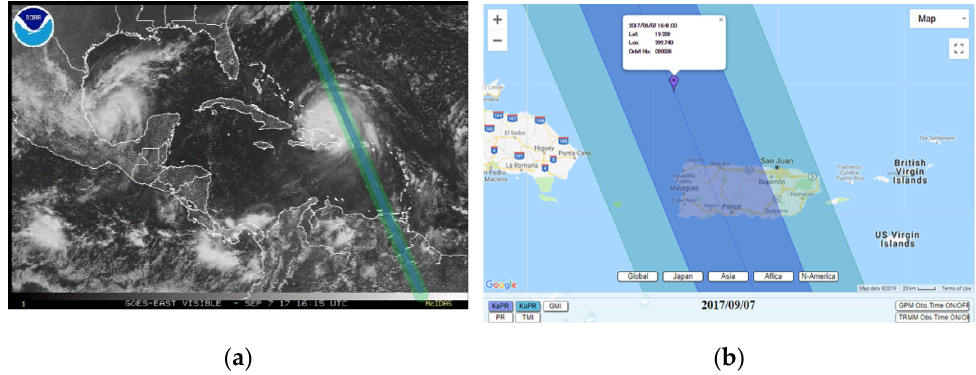
Figure 3. ( a ) GOES East satellite (7 September 2017); ( b ) map of Puerto Rico (7 September 2017).